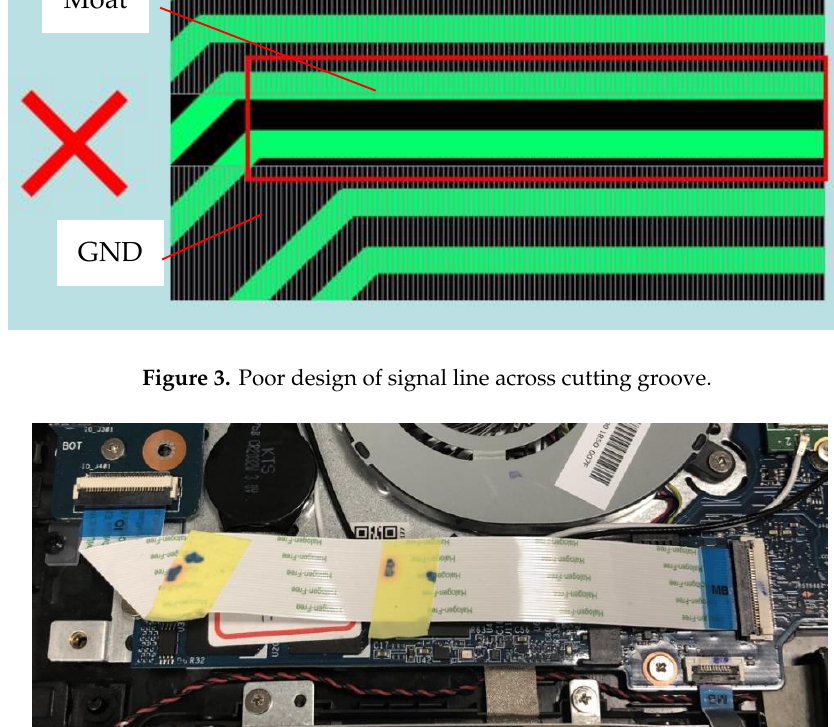
Figure 4. Poor design of overlapping of soft wiring and Solid-state drive.